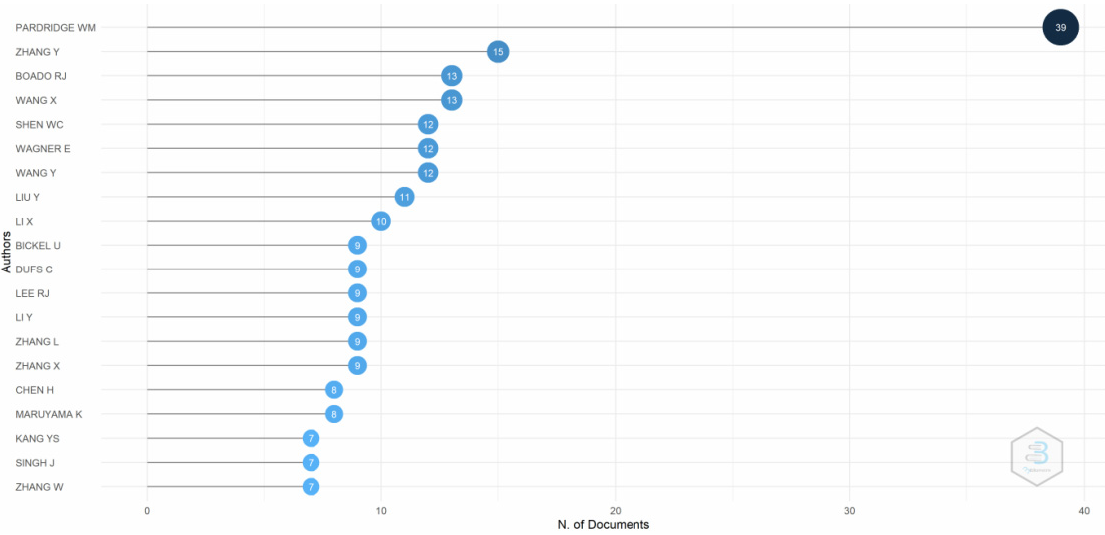
Figure 5. Most relevant authors. Source: Authors’ elaboration using the Bibliometrix R-package.